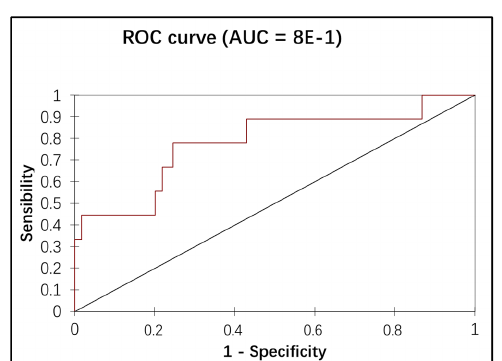
Figure 3. A ROC curve showing the association of stage and lymphovascular space invasion (LVSI) with the presence of low-volume metastasis using logistic regression. The discriminating power of low-volume metastasis detection: the association of two factors (Stage + LVSI) in the logistic regression. ROC = Receiver Operating Characteristic, AUC = Area under the